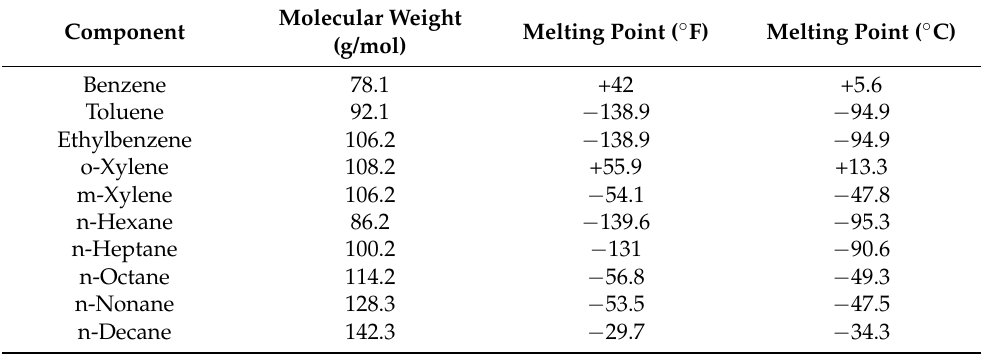
Table 1. Molecular weights and melting points of BTEX and heavy hydrocarbon compounds [3].